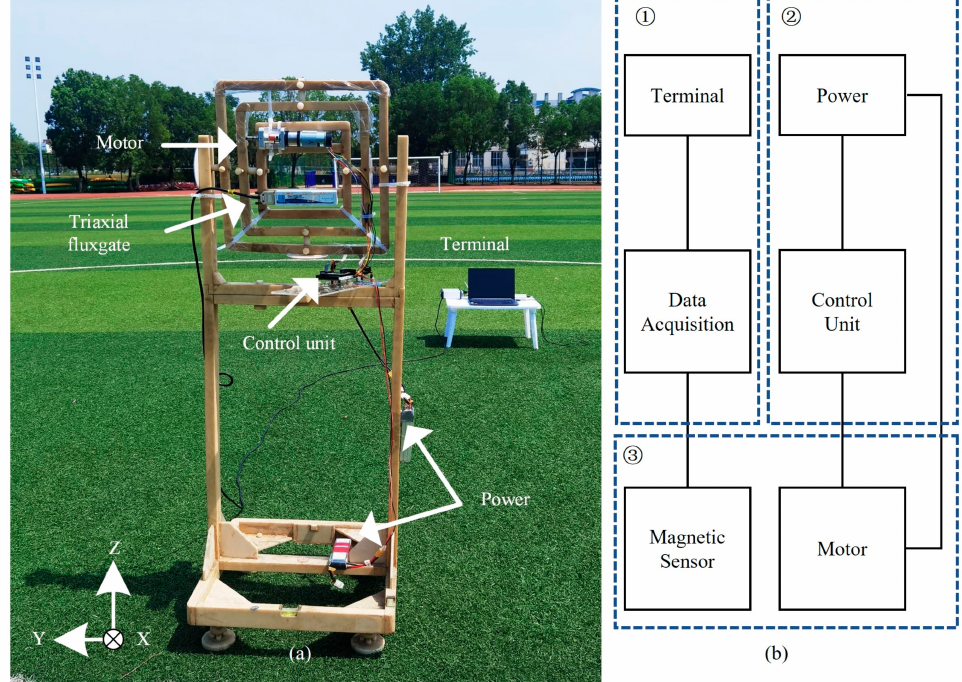
Figure 8. Experimental system and schematic diagram. ( a ) Experimental system; ( b ) Schematic